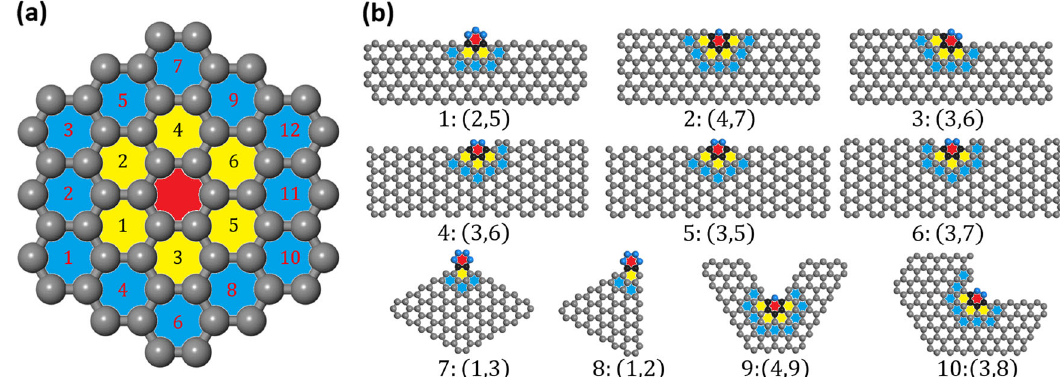
Fig. 1 Structure of a local site in a graphene island and some key events used in the KMC method. a Six nearest neighbors (yellow) and 12 second-nearest neighbors (blue) of a hexagon in a graphene lattice. b Representative events (red) in graphene growth or etching with their corresponding indexes ( m , n ) shown below each event. The blue atoms are those to be added or removed during the event of adding or removal. 1 and 2 are nucleation at zigzag edge during growth and etching, respectively; 3 and 4 are kink propagation at the ZZ and AC edges, respectively; 5 and 6 are armchair nucleation at an armchair edge during growth and etching, respectively; 7 and 8 are events at a convex corner; and 9 and 10 are events at a concave corner,